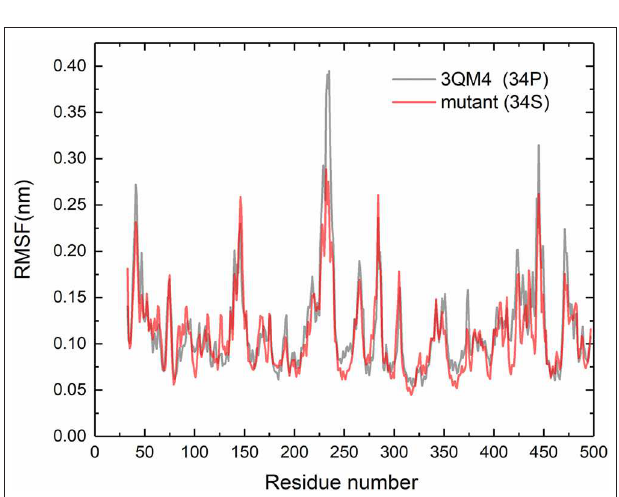
FIGURE 5 | Root mean square fluctuations (RMSFs) for the native (gray) and mutant (red) of CYP2D6.